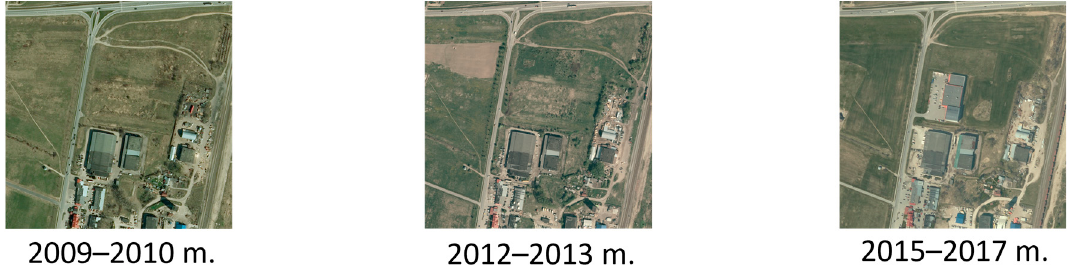
Figure 1. Example of view difference at the same location in different periods.